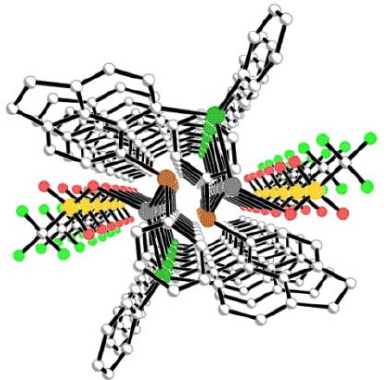
Figure 12. View of the 1D extended helical chain polymer 6 along the z-axis; silver atoms align in two columns with the closest non-bonding Ag···Ag distance 5.929(1)